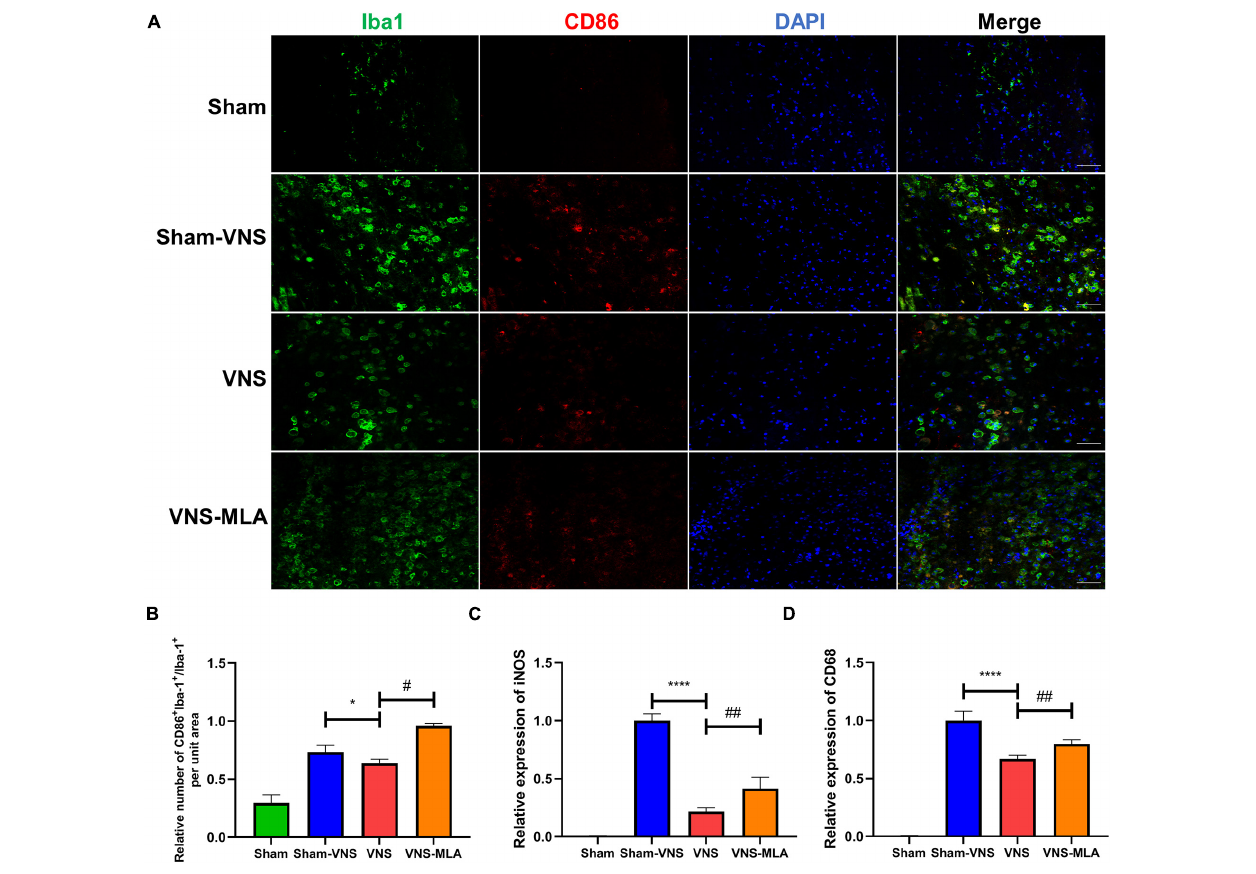
FIGURE 5 | Vagus nerve stimulation (VNS) significantly decreases CD86 production in microglia. (A) Representative images showing Iba-1+/CD86+IF staining after spinal cord injury (SCI), n = 5 per group, scale bar = 50 µ m. (B) Quantitative analysis of the results in panel a, n = 5 per group. (C,D) Relative mRNA expression levels of iNOS and CD68 in all groups, as detected by qRT-PCR, n = 4 per group. * P < 0.05, **** P < 0.0001 VNS vs. Sham-VNS group. # P < 0.05, ## P < 0.01 VNS vs. VNS-MLA